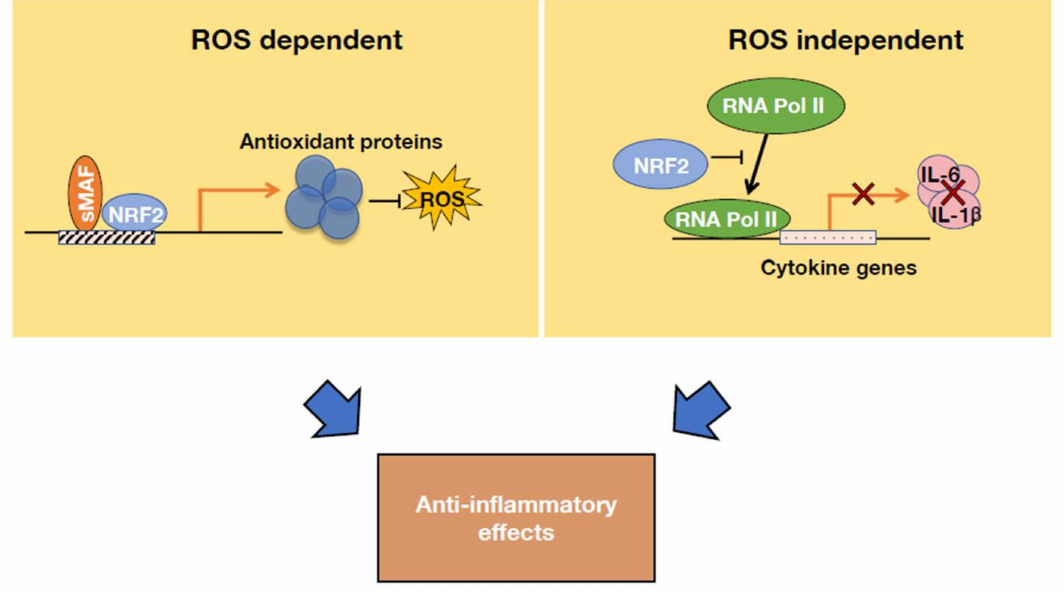
Figure 7. Molecular basis of NRF2 anti-inflammatory activity. NRF2 alleviates inflammation through two diverse mechanisms. First, by inducing the expression of various antioxidant proteins, NRF2 decreases the reactive oxygen species (ROS) levels in cells. Second, NRF2 directly inhibits the transcription of cytokine genes by impeding RNA Pol II